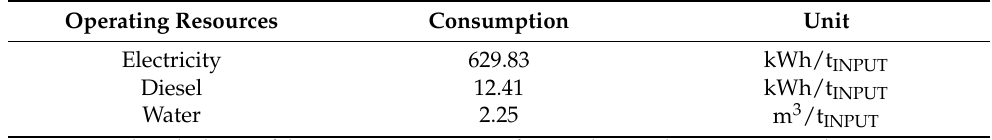
Table 7. Resource consumption of the recycling